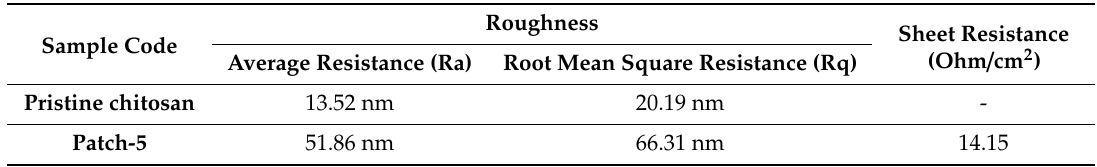
Table 1. Roughness and sheet resistance of chitosan-grafted PAni patch calculated from 2-D, image of height and four-probe technique, respectively.